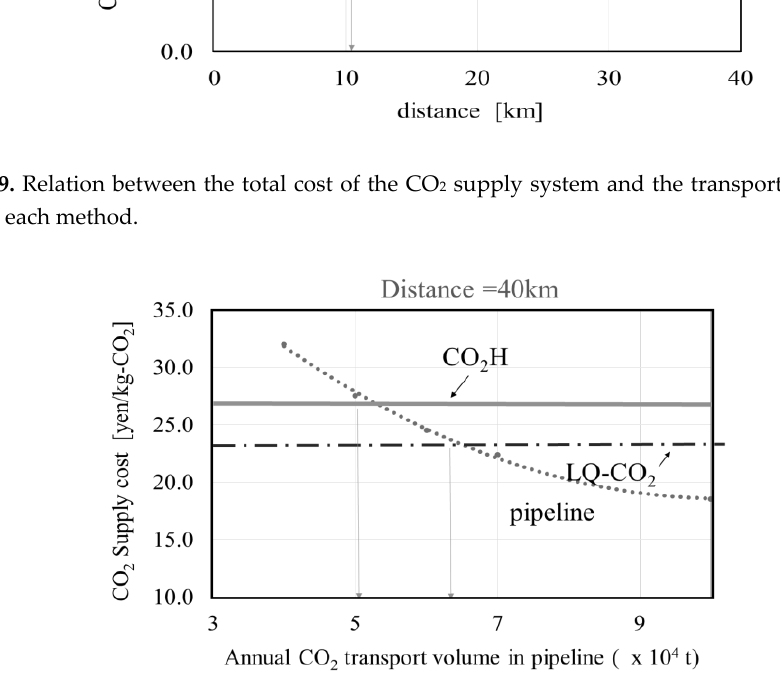
Figure 10. Relation between the total cost of the CO 2 supply system and the annual CO 2 transport volume in